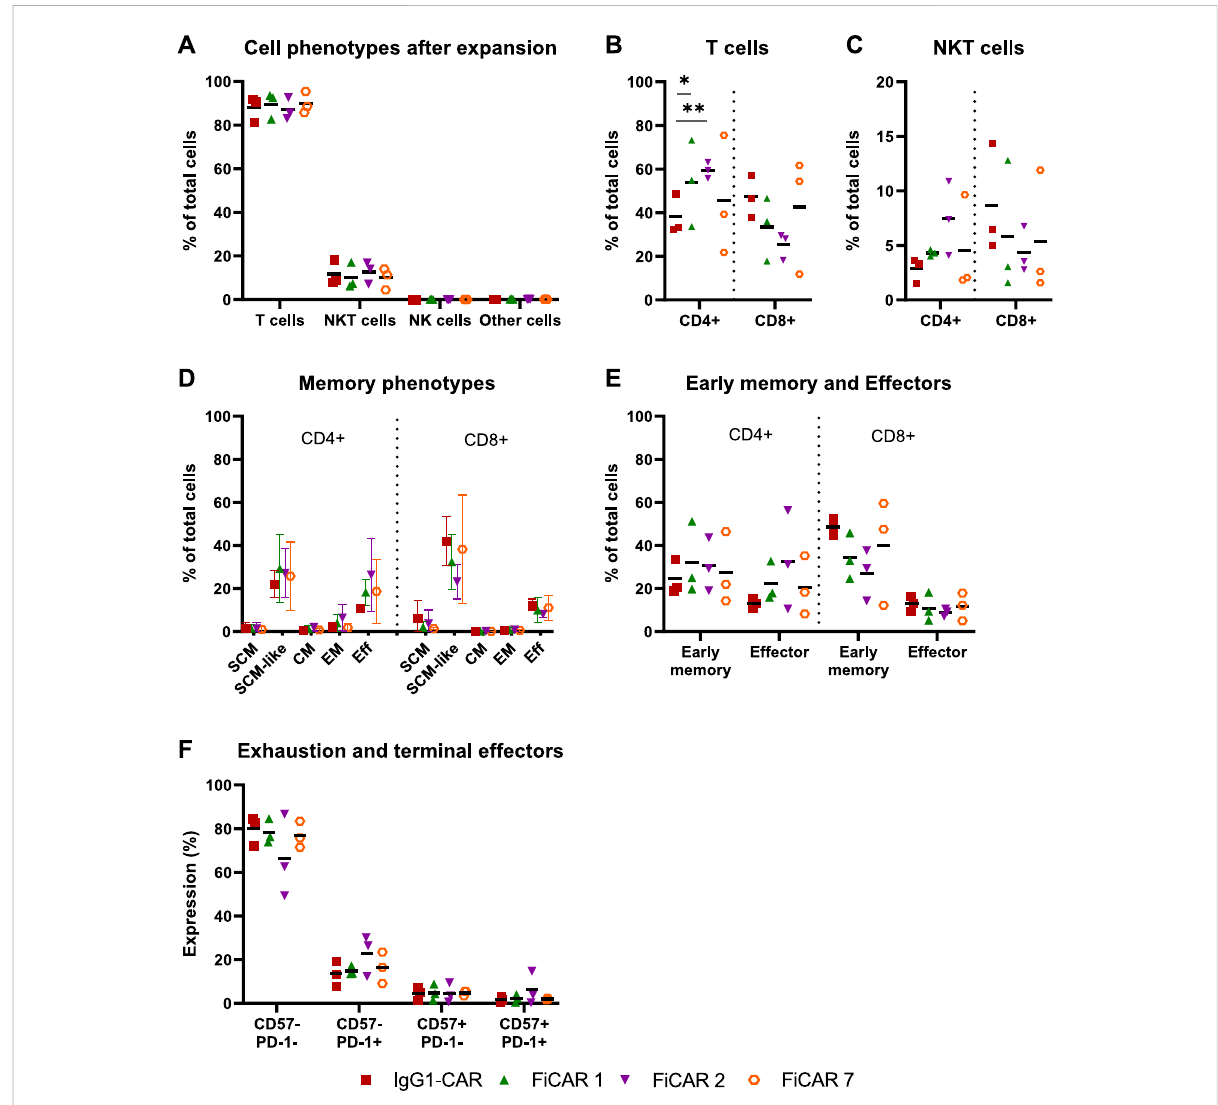
results of mock T cells (13.25 ± 5.2) (Figure 1D and Supplementary Figure S1B). Representative gating strategies are shown in Supplementary Figure